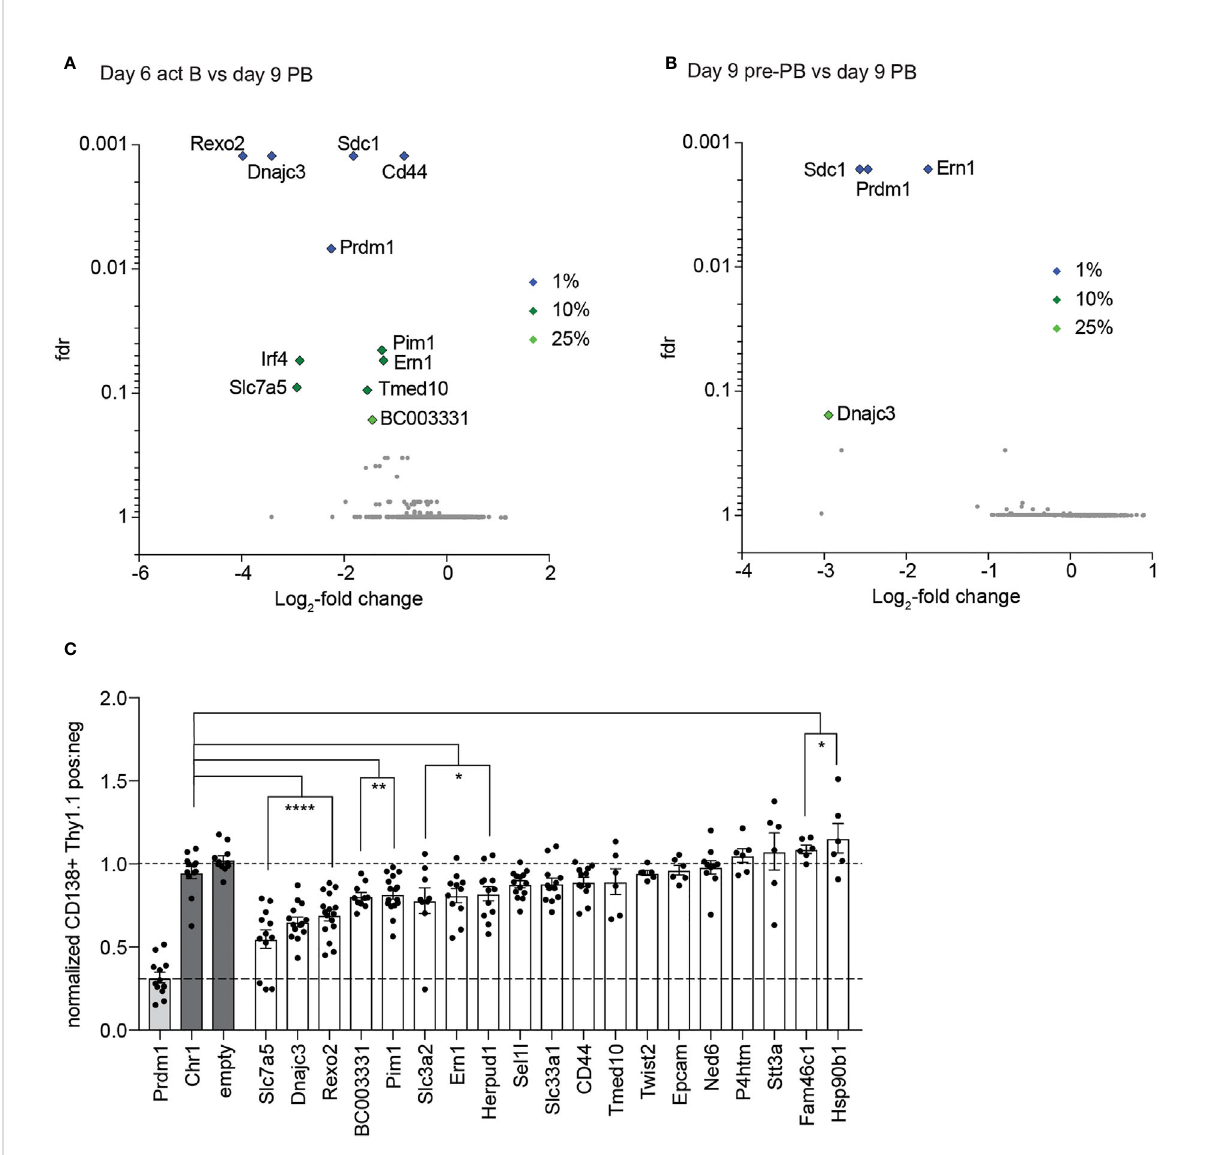
FIGURE 2 Results of screen 1. (A, B) Results of screen 1. Volcano blots, depicting the negative enrichment of sgRNAs, from the comparison act B vs PBs (A) and pre-PBs vs PBs (B) . Fdr= false discovery rate. (C) Single guide validation of fi rst screen. The ratio of the amount of PBs in the Thy1.1 negative and positive population was calculated and normalized to the average of the value of the negative controls Chr1 (targeting a gene free region on Chromosome 1) and empty vector (the plasmid without sgRNAs). Top two performing sgRNAs from the screen were used for each gene. Each dot represents a replicate. All statistical data show as mean values with SEM; *P < 0.05; **P < 0.01; ****P < 0.0001 (Student ’ s t